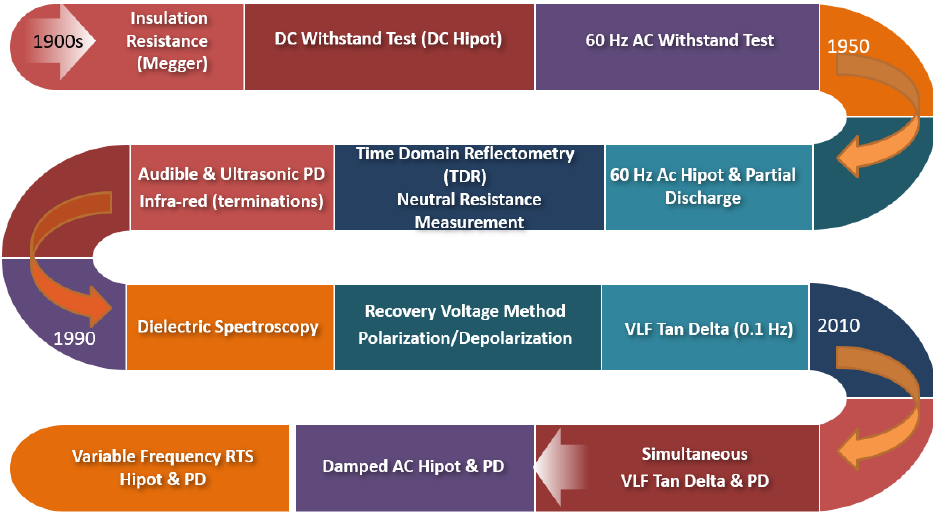
Figure 2. Evolution of testing techniques for UGPCs. UGPC testing has evolved from basic Go/No-Go tests, such as insulation resistance, DC and AC, to withstand more advanced diagnostic tests, such as VLF Tan-delta, partial discharge (PD), time domain re fl ectometry (TDR), and variable frequency resonant test sets (RTS), for performing Hipot and PD.